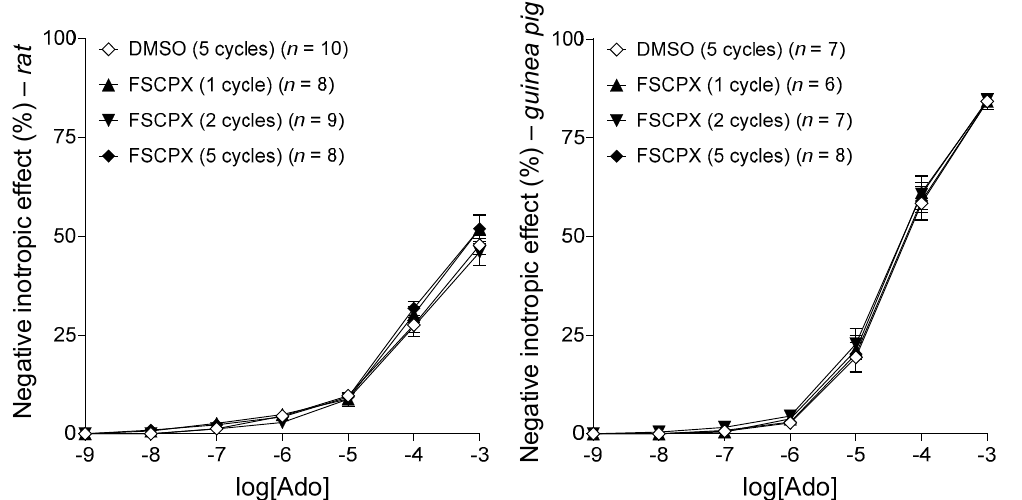
Figure 7. The direct negative inotropic effect of adenosine in the isolated rat ( left panel ) and guinea pig ( right panel ) left atrium, divided into four groups, handled uniformly at this stage of the investigation (thus, the group names refer to subsequent in vitro treatments). The x -axis shows the common logarithm of the molar concentration of adenosine (in the bathing medium), and the y -axis denotes the effect (as a percentage decrease in the initial contractile force). The symbols indicate the responses to adenosine averaged within the groups (± SEM). Ado: adenosine; FSCPX: 8-cyclopentyl- N 3 -[3-(4- (fluorosulfonyl)benzoyloxy)propyl]- N 1 -propylxanthine; DMSO: dimethyl-sulfoxide.